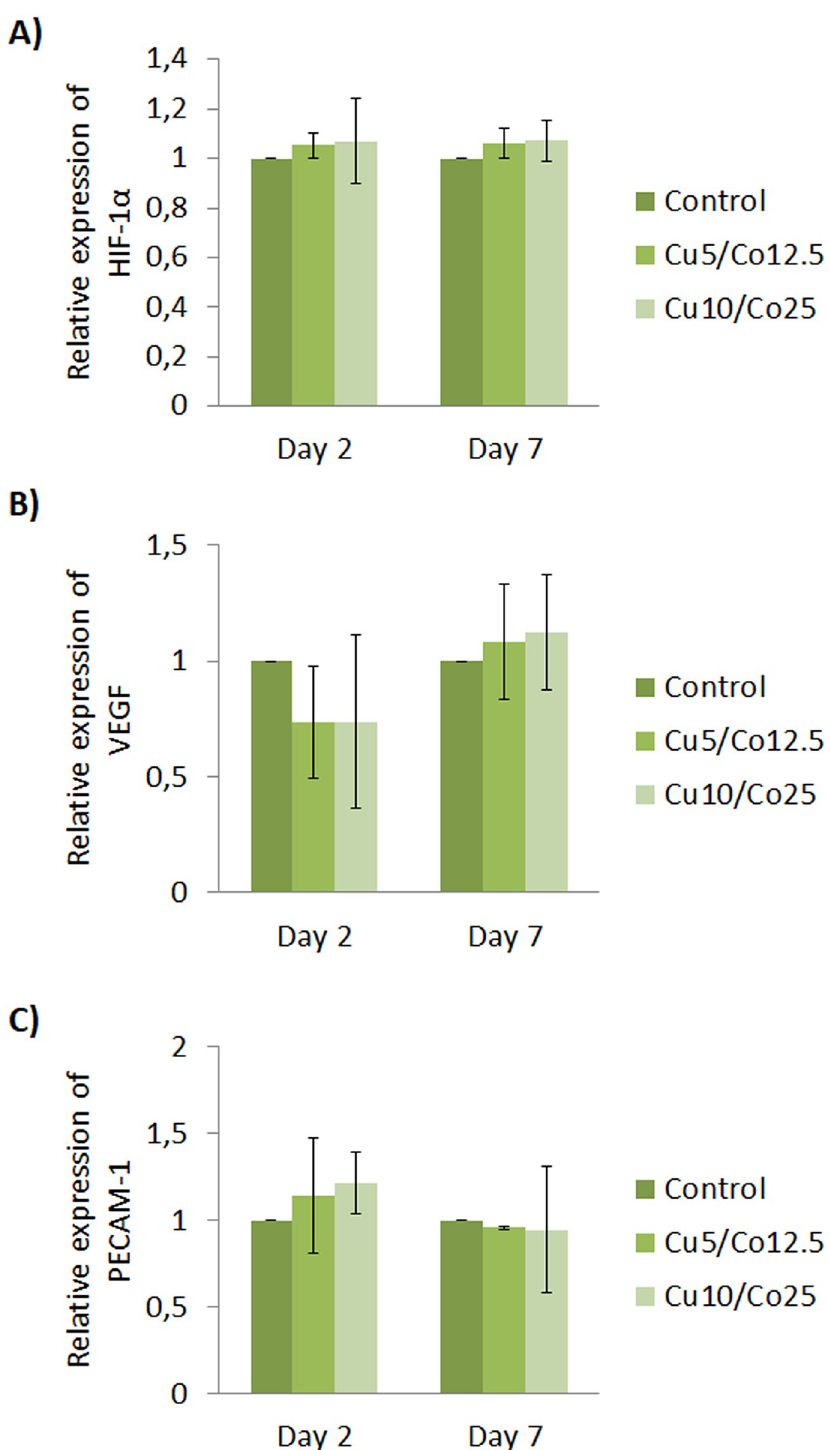
Fig 8. HUVEC gene expression. Different Cu 2+ and Co 2+ concentrations were evaluated at 2 and 7 days for the expression of (A) HIF-1 α , (B) VEGF and (C) PECAM-1. Data represented correspond to fold-changes compared each time point control. Abbreviations: Cu5/Co12.5 = 5 μ M of Cu 2+ and 12.5 μ M of Co 2+ ; Cu10/Co25 = 10 μ M of Cu 2+ and 25 μ M of Co 2+